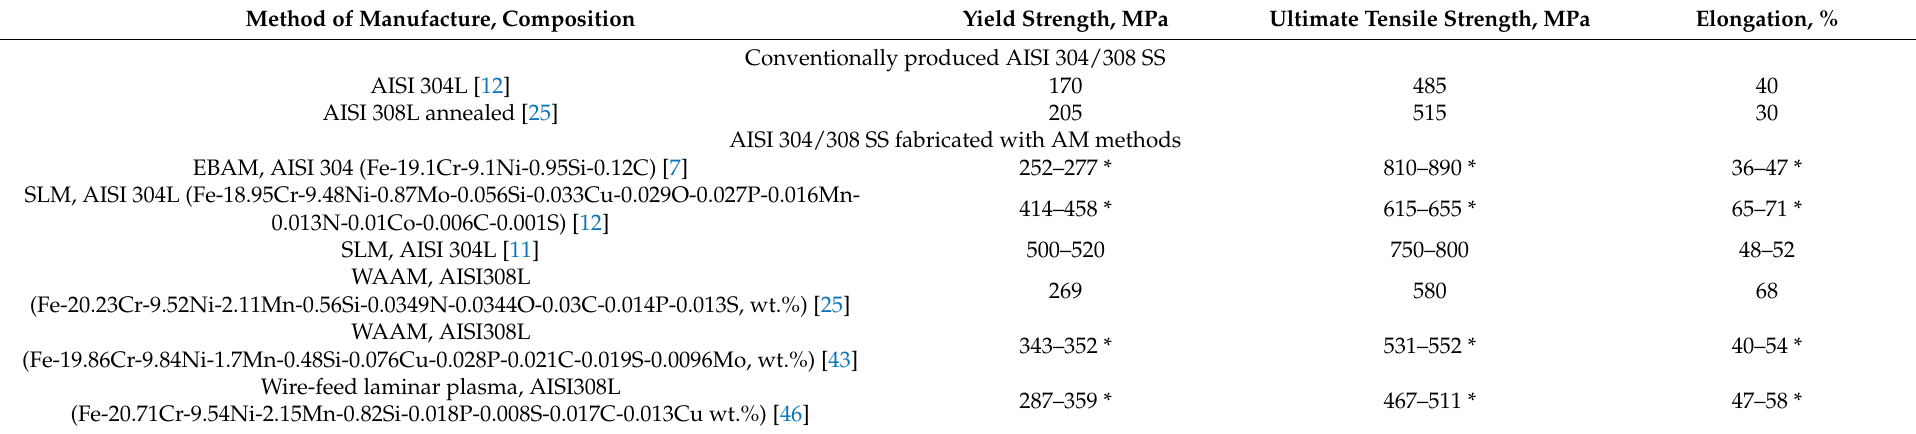
* Intervals indicate the variation of the mechanical properties due to the anisotropy of the